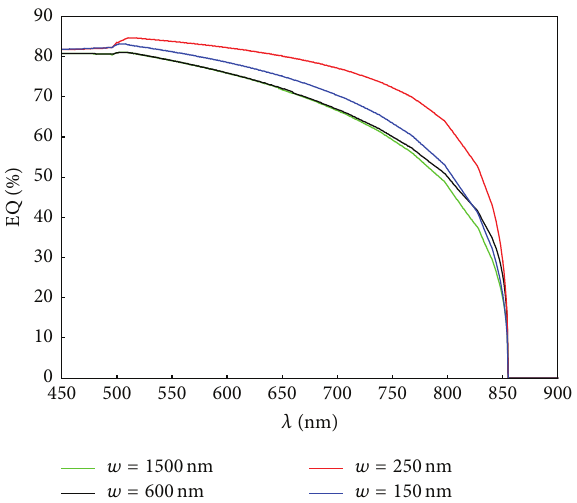
Figure6: Quantumefficiency curves fordifferent values ofabsorber